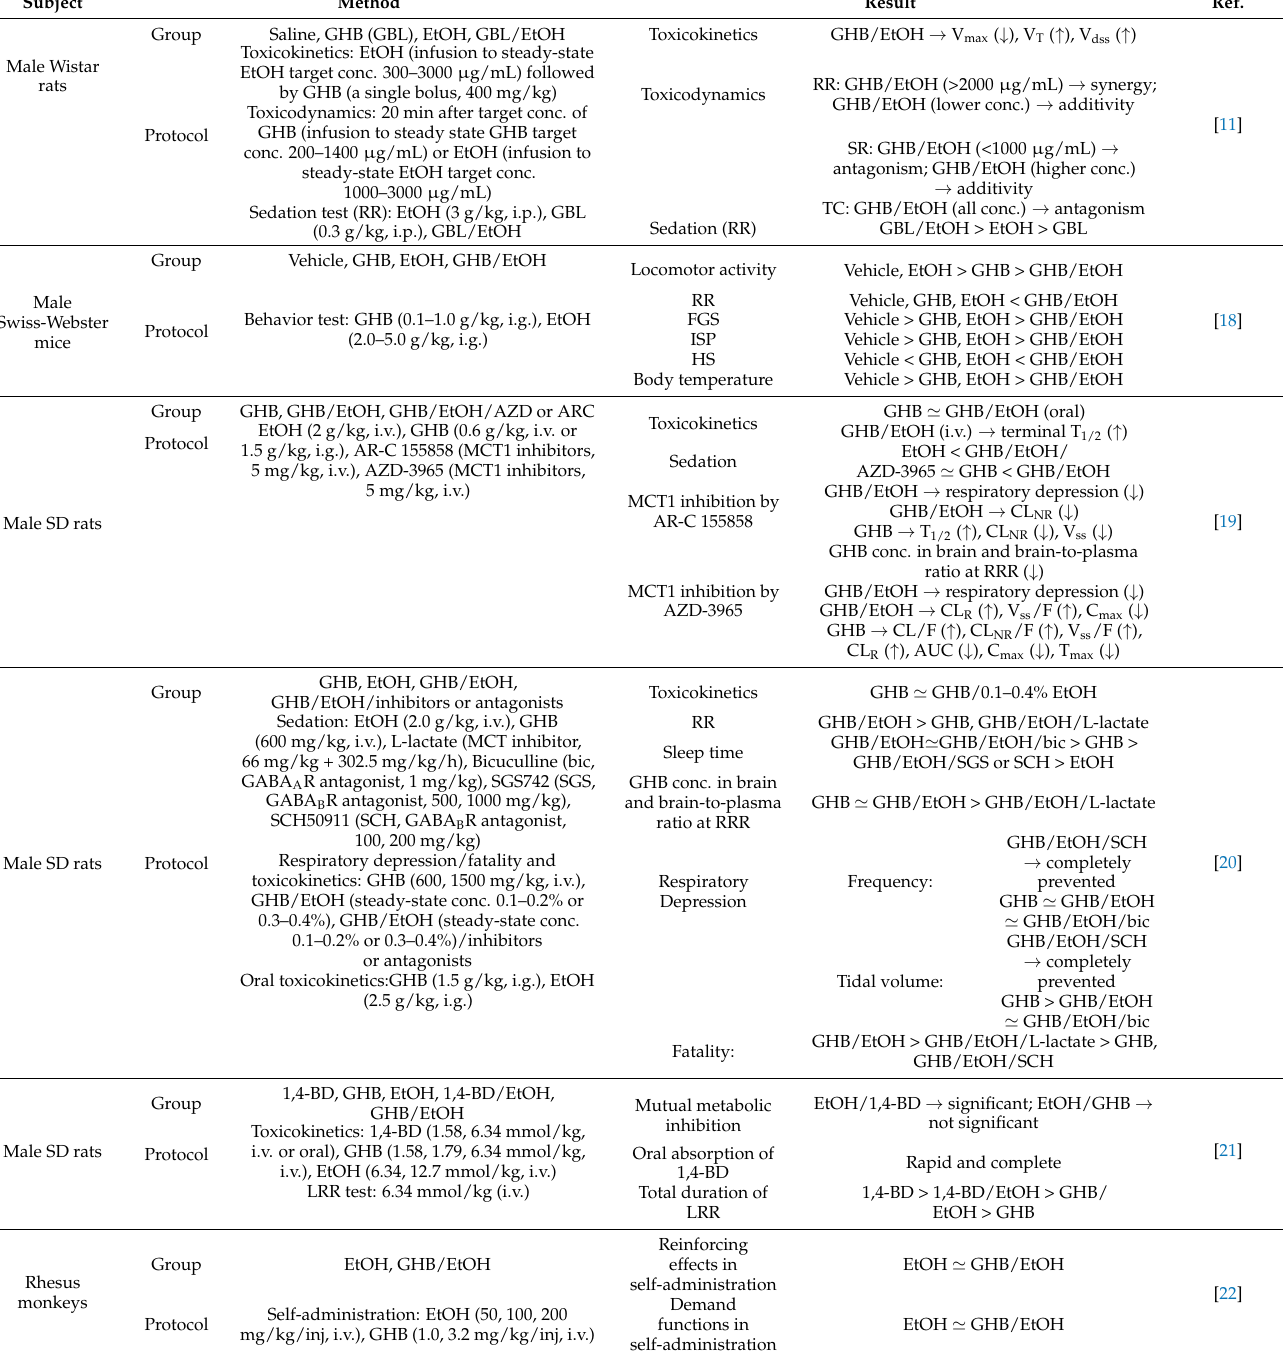
Table 3. Animal studies on toxicokinetic and toxicodynamic changes in gamma-hydroxybutyric acid (GHB) following co-administration of